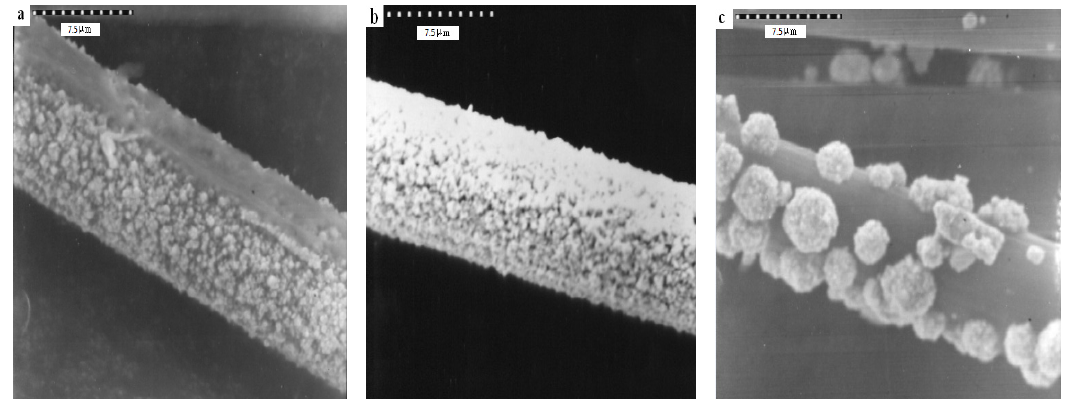
Figure 11. Gold particles distribution on a bundle of carbon fiber is composed of 8 single fiber and their lengths: ( a ) 6 cm; ( b ) 8 cm; ( c ) 12 cm.